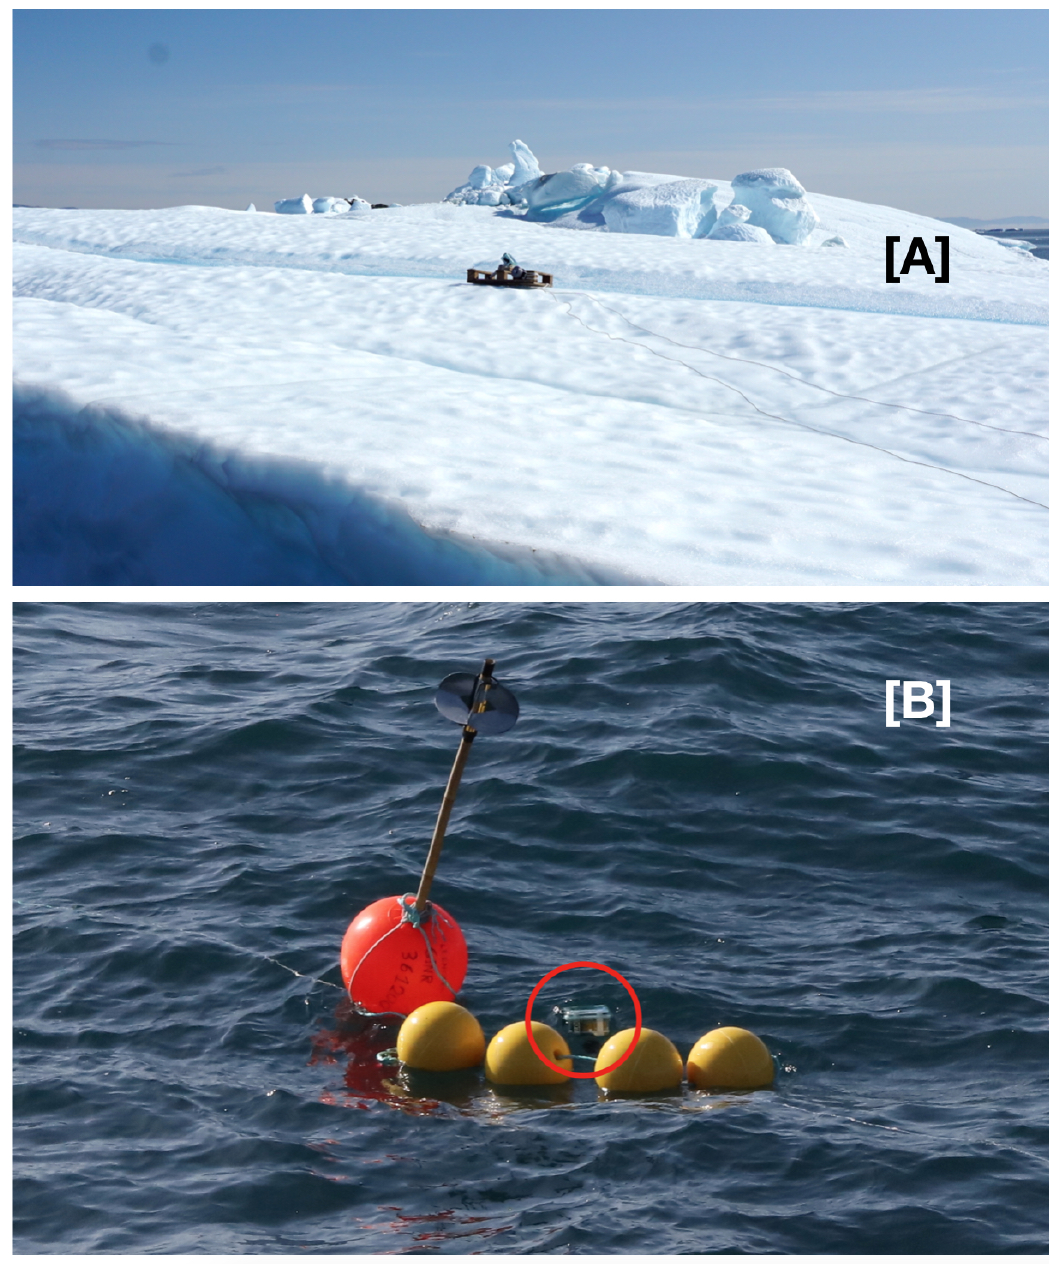
Figure 6. ( A ) A drifting buoy variant of the Maker Buoy was deployed on an iceberg to permit repeat surveys during the Vaigat Iceberg—Microbial Oil degradation and Archaeological heritage investigation (VIMOA) cruise in August 2019 (Photo credit: M.J. Walsh). ( B ) A drifting buoy variant of the Maker Buoy (red circle) was attached to the freely drifting mooring that was deployed and retrieved during the VIMOA cruise in August